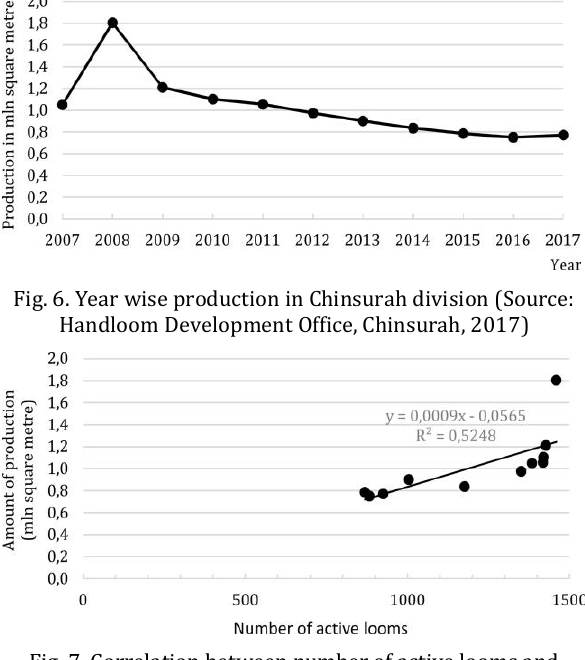
Fig. 7. Correlation between number of active looms and amount of productions (Source: Handloom Development Office, Chinsurah,